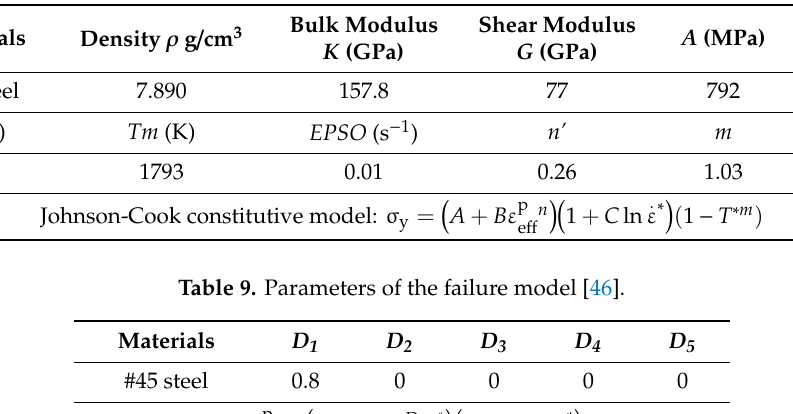
Figure 13. Numerical simulation model of impact energy release behavior. Table 8. Parameters of the constitutive model [46].